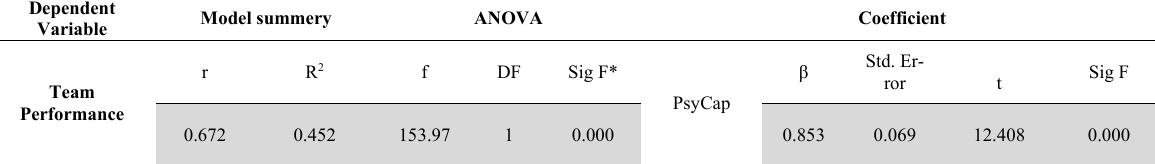
Table 10 indicates that the value of (r = 0. 672), which means that there is a positive correlation value of (67.2%) which is considered to be high between (Psychological capital) and (Team Performance) in advertising agencies in Amman city. The coefficient of determination value (R 2 = 0.452), which means that the variation in (Psychological capital) has explained (45.2%) of the variance in (Team Performance), as the analysis of variance shows that the value of (f) has reached (153.97) when Confidence level (sig = 0.000) and confirms the significance of regression at (  ≤ 0.05) level, and at one degree of freedom. From the coefficient table, the value of ( β =0.853), meaning that the increase in one unit in the (Psychological capital) variable in advertising agencies in Amman city leads to an increase by (85.3%) in (Team Performance), and the value of (t = 12.408) at a confidence level (sig = 0.000) This confirms the coefficient significance at (  ≤ 0.05) level. Based on the